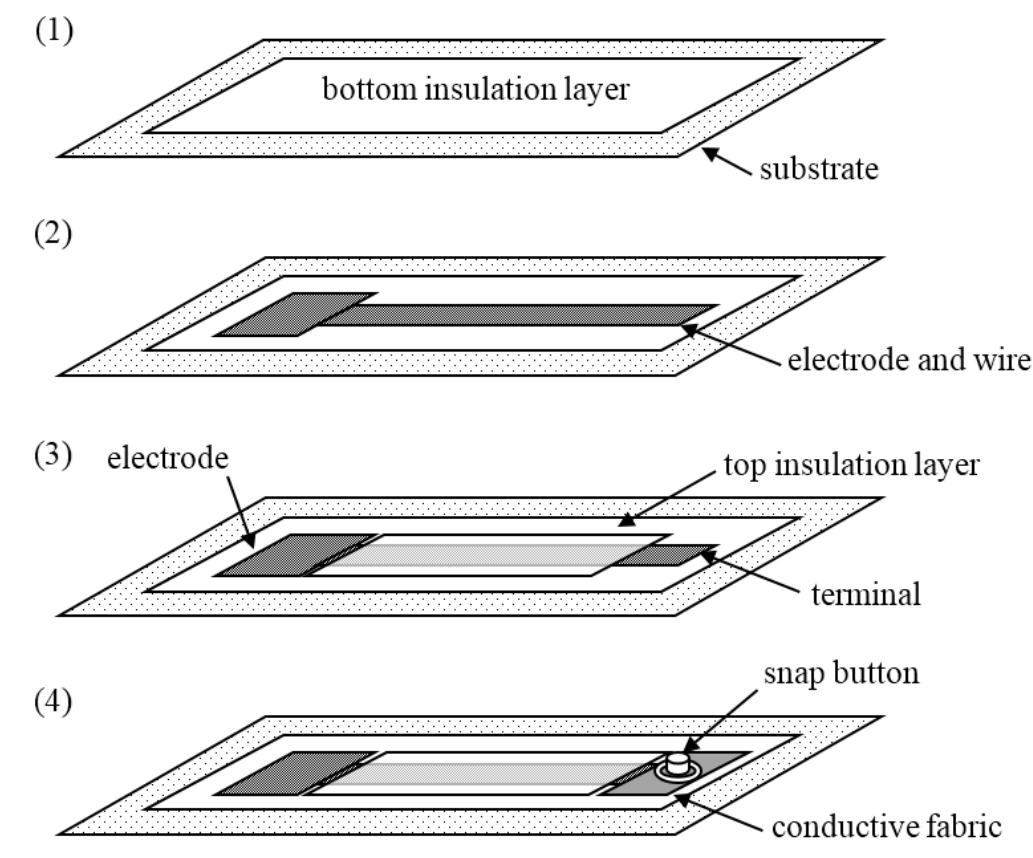
Figure 2. Procedure of the manufacture of the conductive ink electrode and wire